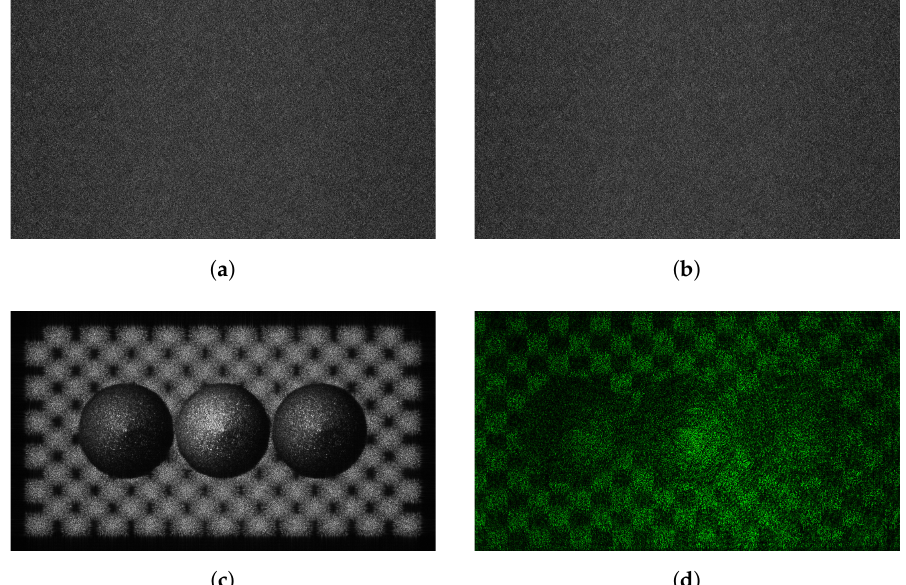
Figure 11. Visual result of the hologram which is watermarked in the amplitude domain ( a ) original and ( b ) watermark embedded hologram, ( c ) numerical and ( d ) optical reconstruction result (hologram : 38.619 dB, phase : 34.874 dB, reconstruction : 41.659